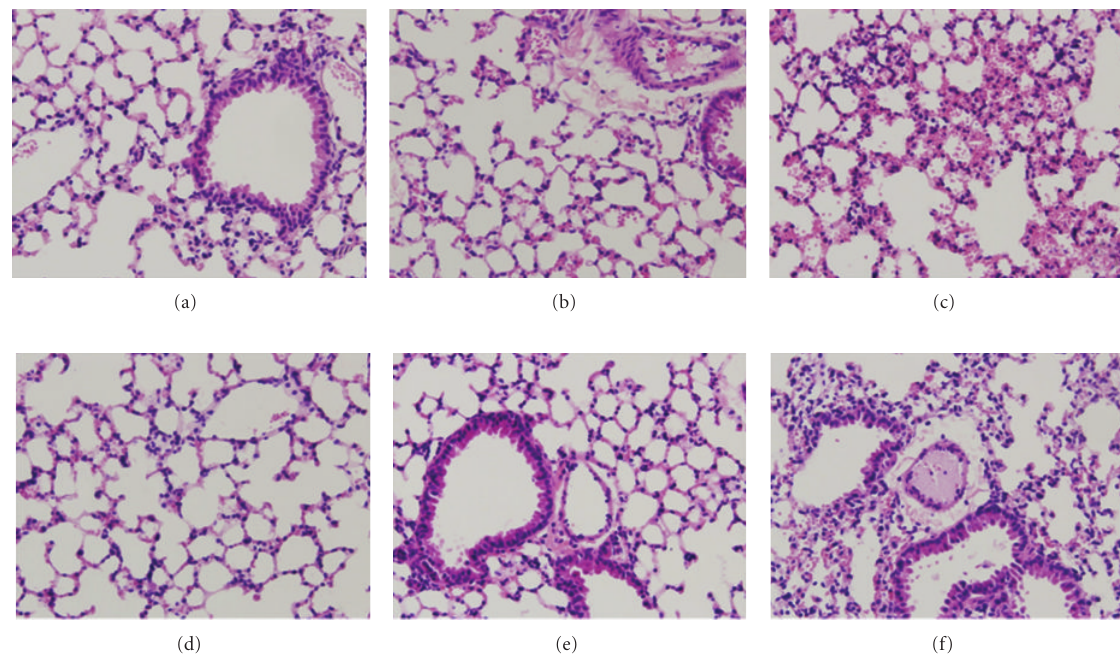
Figure 5: Histological specimens from lungs of control mice (a and d) and mice ventilated with lower tidal volumes (L V T ; b and e) or higher V V T (H T ; c and f) for 5 hours. Upper panel, represent wild-type mice (TF + (TF + / − ). Hematoxylin-eosin stain; magnification 200 ×